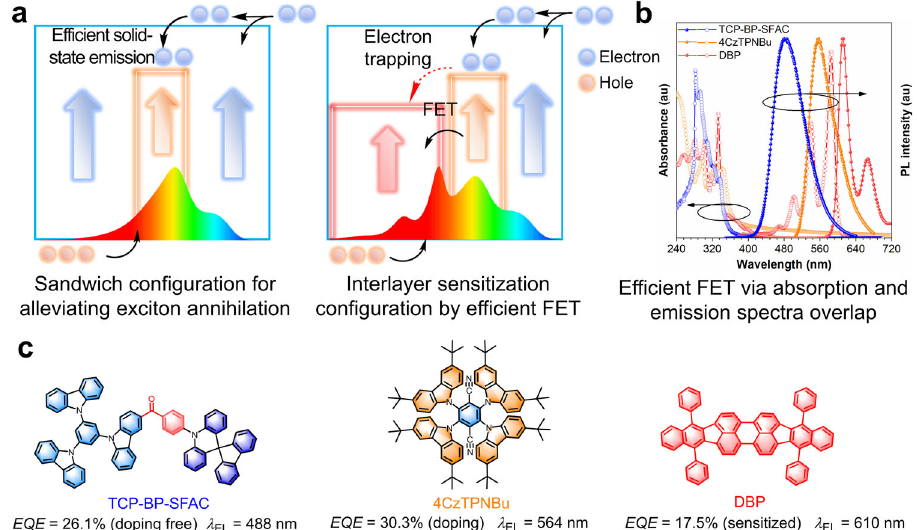
Fig. 1 | Design principle and materials information of WOLEDs. a Schemical mechanisms of sandwichcon fi gurationdesignand interlayersensitizating system. b Absorption and photoluminescence (PL) spectra of sky-blue emitter TCP-BP- SFAC, orange emitter 4CzTPNBu and red emitter DBP applied in all- fl uorescence